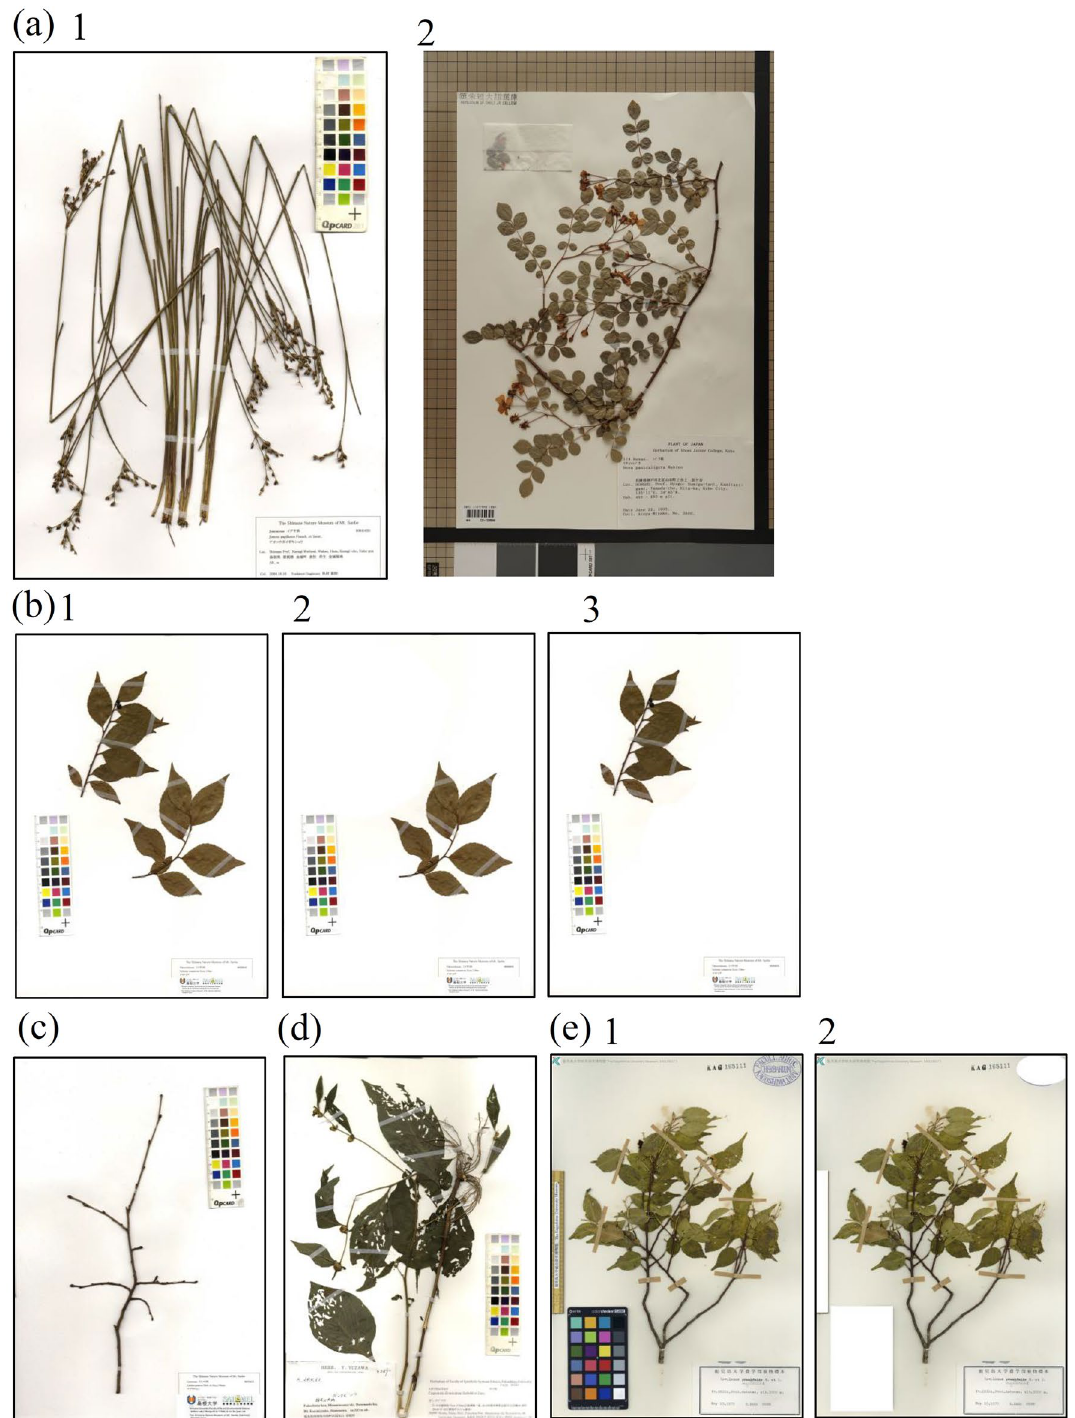
Figure 1. Specimen images taken with a scanner ( a 1) and with a camera ( a 2). ( b 1) Multiple individuals in one specimen image and ( b 2) image divided into two. ( c ) Specimen images showing only branches and leaves that have fallen. ( d ) Specimen image with many holes in a leaf eaten by insects. ( e 1) Specimen image with a scale, stamp, and colour bar and ( e 2) the image after the scale, stamp, and colour bar were